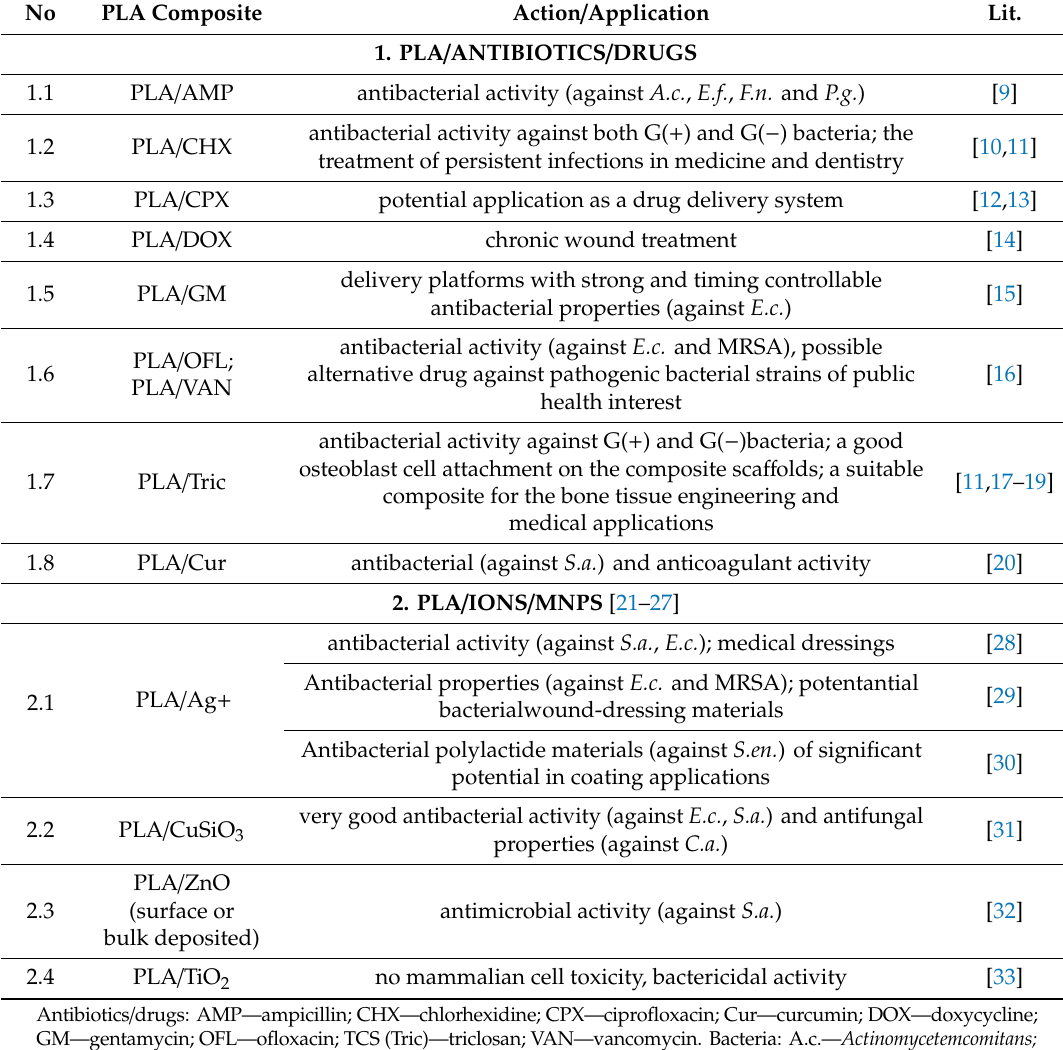
Table 1. Representative application of antibacterial poly(lactide) (PLA)